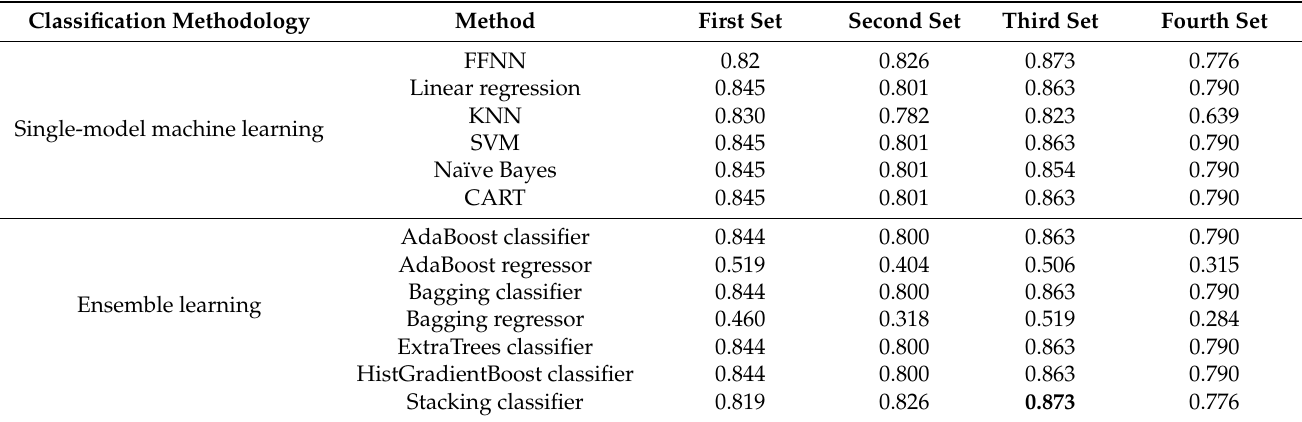
Table 6. Accuracy of classifiers on the SemEval-2017 dataset (of two-class classification without considering the neutral class) with different sets of emotions. The best result is shown in bold.